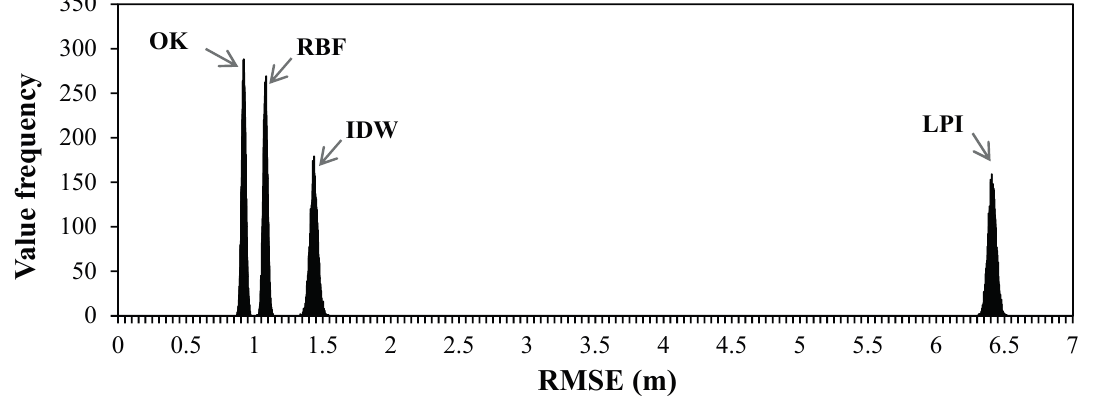
Figure 6. Histograms showing the results of Monte Carlo